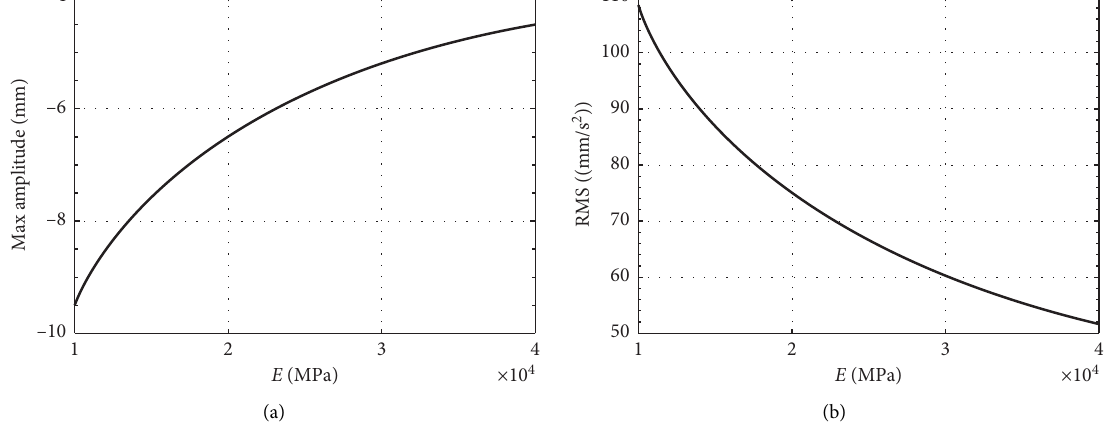
Figure 6: (a) Midspan deflection of the considered beam element in Table 2, and (b) root mean square (RMS) of the solution of equation (3) as functions of the elastic modulus of concrete.